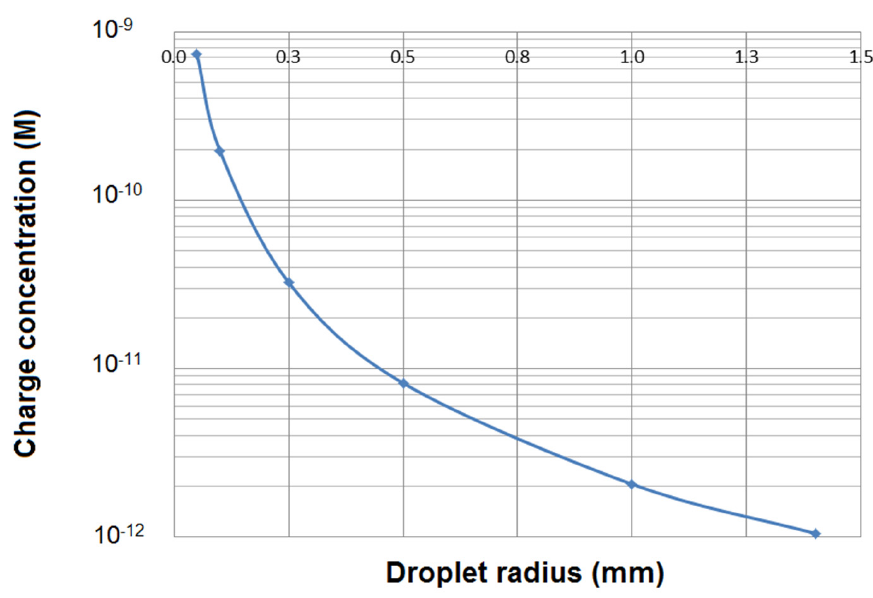
Figure 3. Calculated dependence of the volume concentration of elementary charges on the distance from the center of the droplet. The droplet diameter is 2.8 mm (accordingly, its radius is r 0 = 1.4 mm). The non-zero concentration of elementary charges in the center of the droplet, in- dependent of its total net charge, is a feature of the solution of differential Equation